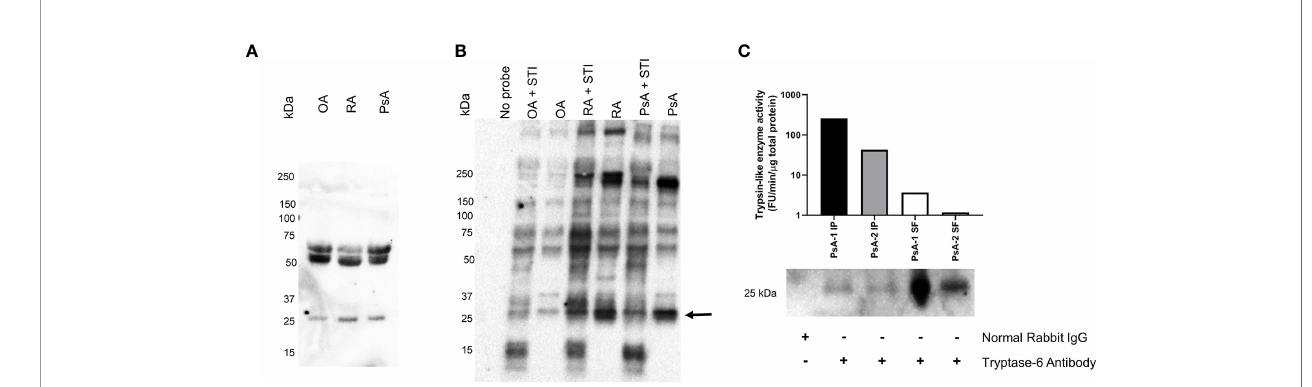
FIGURE 4 | Synovial fl uid tryptase-6 aligns with active serine proteinases from PsA, OA and RA patients. Tryptase-6 was detected by western blot analysis of individual SF samples from PsA, OA and RA patients (A) . In parallel, trypsin-like serine proteinase activity was identi fi ed in SF samples from the same individuals after covalent labelling with a biotinylated ABP probe for trypsin-like serine proteinases in the presence or absence of the trypsin inhibitor, STI (4 µg/ml), and visualization by western blot detection using streptavidin-HRP (B) . An ABP-labelled band at the predicted molecular weight of active tryptase-6 (~25 KDa), for which labelling was reduced in the presence of STI was observed (arrow, B ). A column-based antibody af fi nity chromatography procedure was used to isolate tryptase-6 from PsA SF samples (n=2). The activity of the isolated enzyme and its identity were con fi rmed by its ability to cleave the substrate, VPR-AMC, and by western blot detection with a tryptase-6 antibody, respectively (C) .